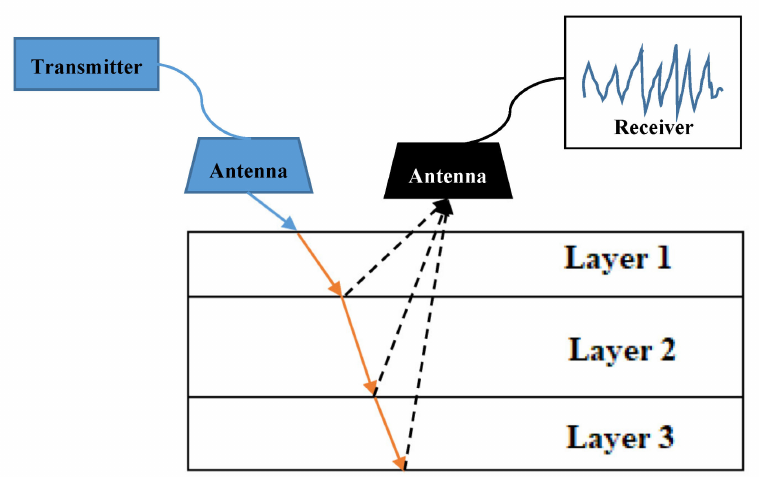
Figure 3. Ground Penetrating Radar principle of